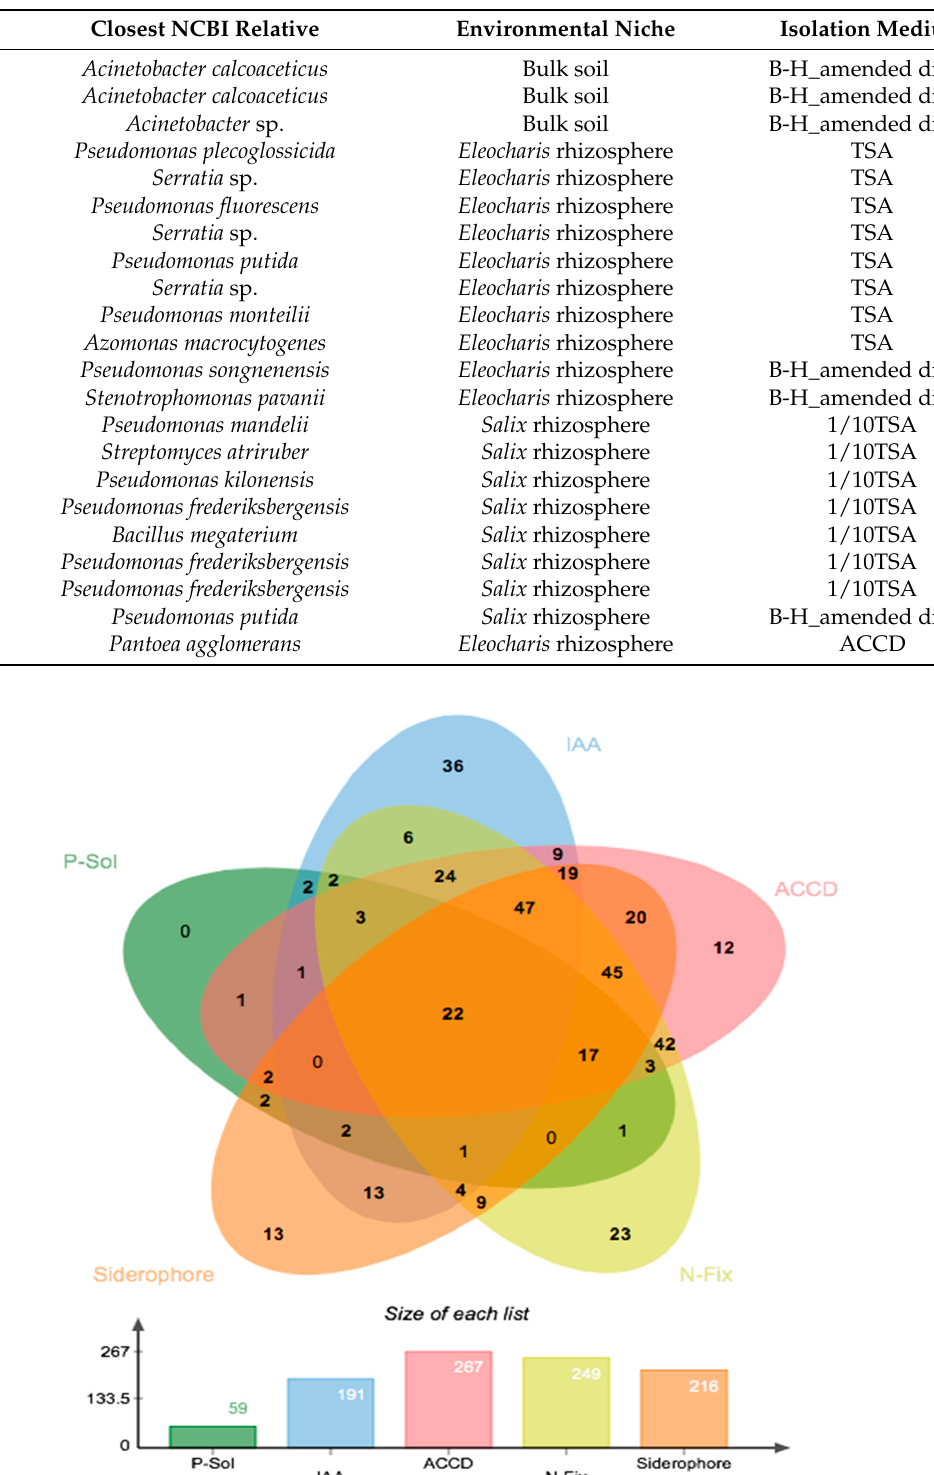
Table 2. List of bacterial isolates that possessed all five-plant growth-promoting traits that were tested in this study.